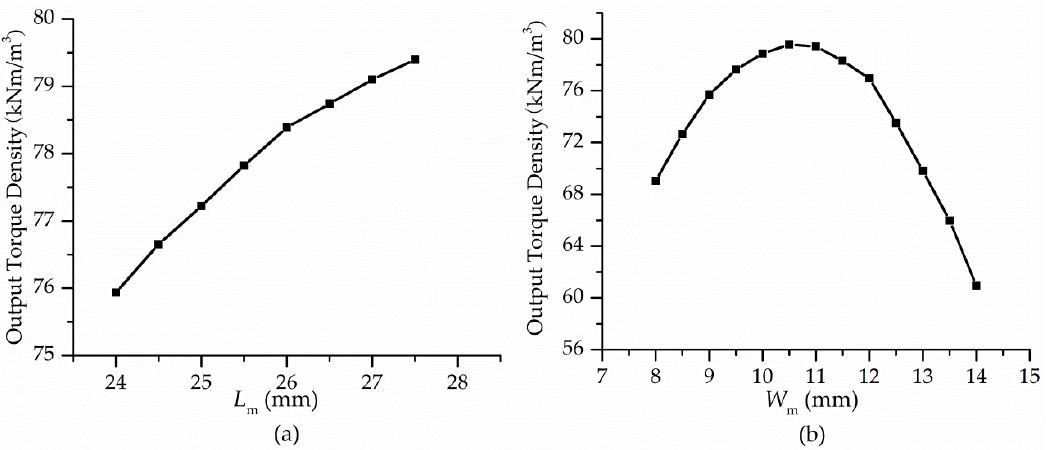
Figure 7. Output torque density curves versus L m and W m . ( a ) Length of rectangular shape modulation pieces; ( b ) Width of rectangular shape modulation pieces.